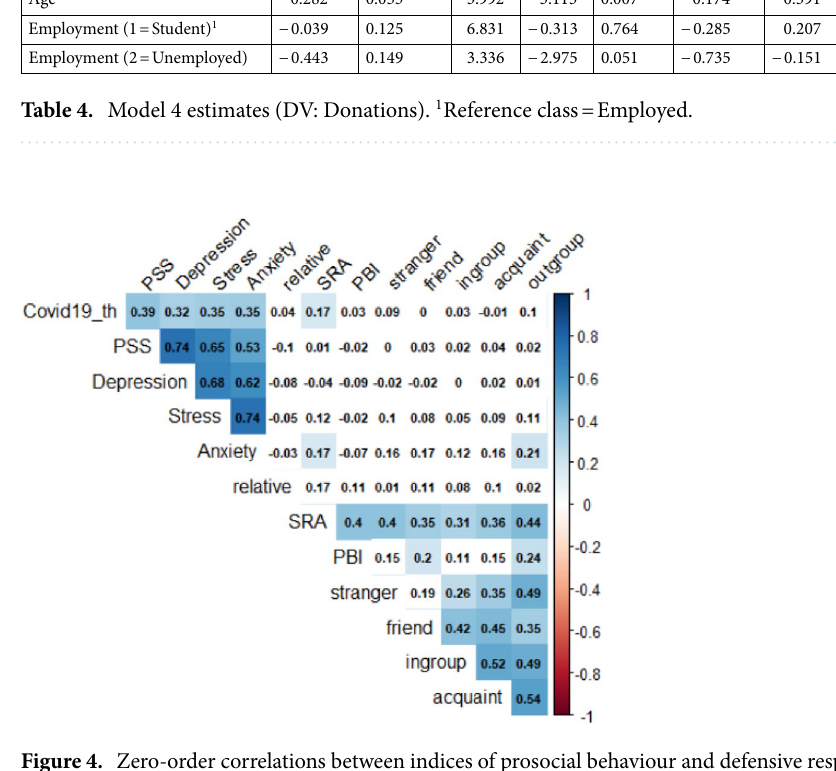
Figure 4. Zero-order correlations between indices of prosocial behaviour and defensive responses. The numbers in each cell correspond to the Pearson r coefficients. Cells with a white background correspond to correlations that did not survive correction for multiple comparisons. Covid19_th: Perceived COVID-19 threat; PSS: Perceived Stress Scale; Depression: DASS-21 Depression scale; Stress: DASS-21 Stress scale; Anxiety: DASS- 21 Anxiety scale; SRA: Self-report Altruism; PBI: Prosocial Behavioural Intentions scale; stranger: Frequency of altruistic acts towards stranger; friend: Frequency of altruistic acts towards a friend; relative: Frequency of altruistic acts towards a relative; ingroup: Frequency of altruistic acts towards an ingroup member; outgroup: Frequency of altruistic acts towards an outgroup member; acquaint: Frequency of altruistic acts towards an